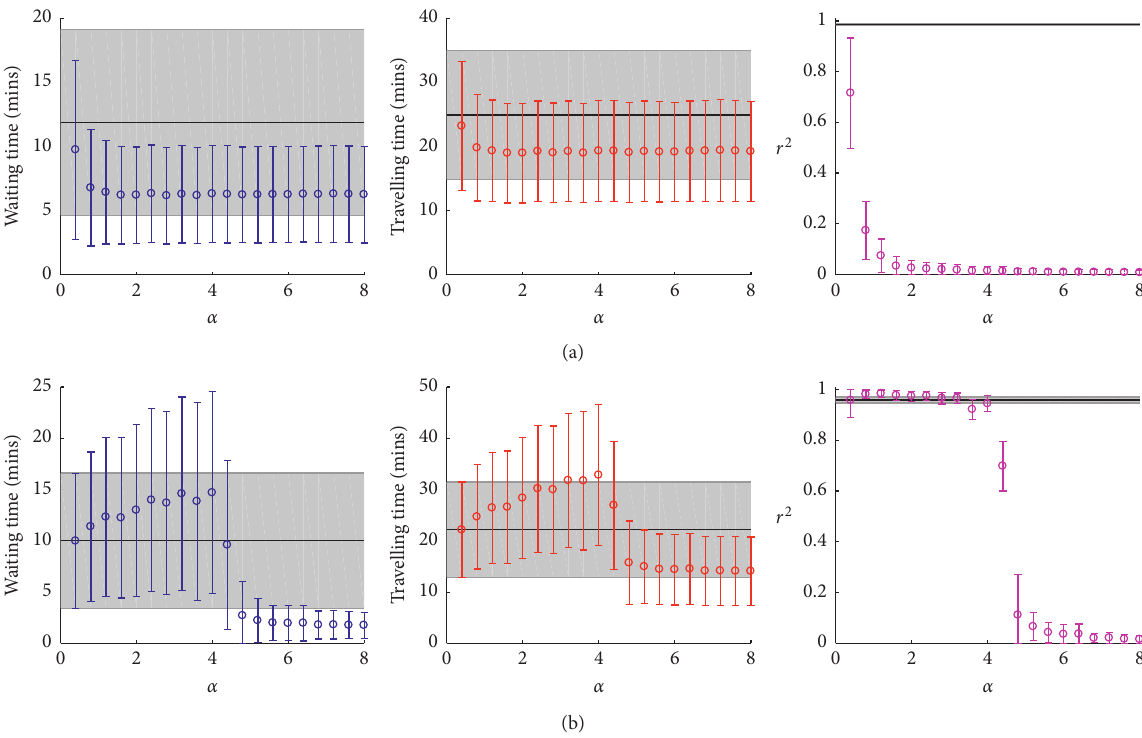
Figure 7: Results of the c-holding strategy in the two same-velocity scenarios. Each colored point represents the mean and standard deviation of the measured quantities calculated from 100 realizations of each parameter value. The black line and grey shaded area of each graph denote the mean and standard deviation of the measured quantities from a control case, which are simulation runs of the same parameter values, without any intervention strategies. (a) C-holding strategy in lull-same. (b) C-holding strategy in